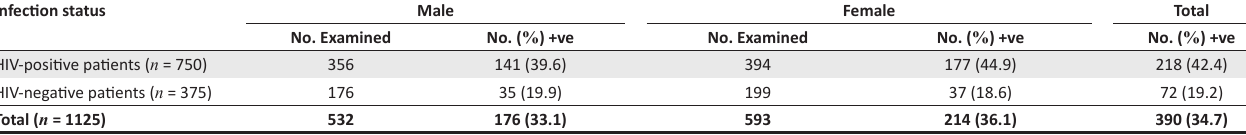
TABLE 1b: Prevalence of Microsporidiasis amongst HIV-positive and -negative patients by gender ( n = 1125). Infection status Male Female